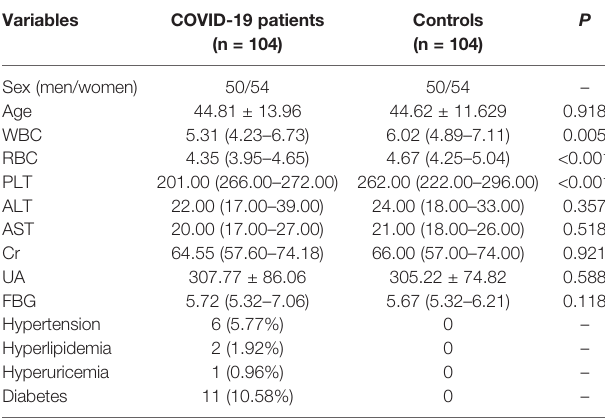
TABLE 1 | Characteristics of study participants.